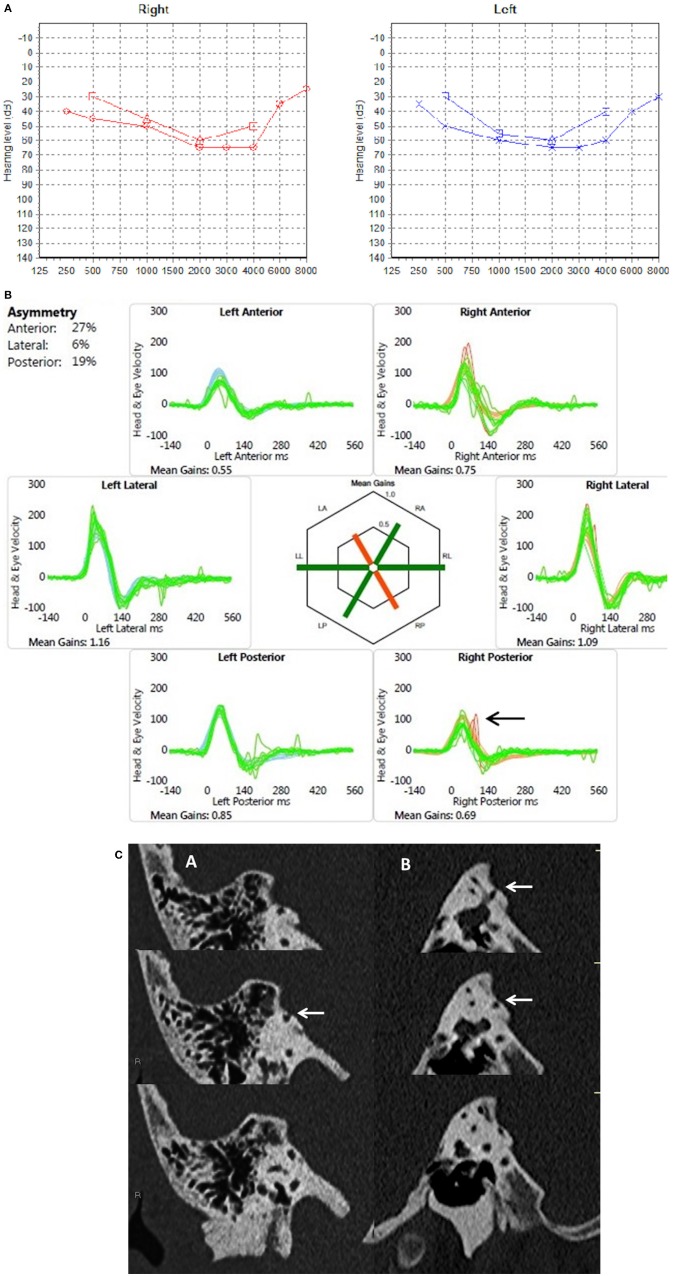
(A) PTA in a child presenting with mixed hearing loss (child 1). (B) Video head impulse test in same child with at least 2 covert replicable saccades in the right posterior semicircular canal (arrow). (C) Coronal (A) and sagittal (B) reconstructions of a high resolution CT scan with consecutive slices demonstrating dehiscence of the right posterior semicircular canal (arrows).